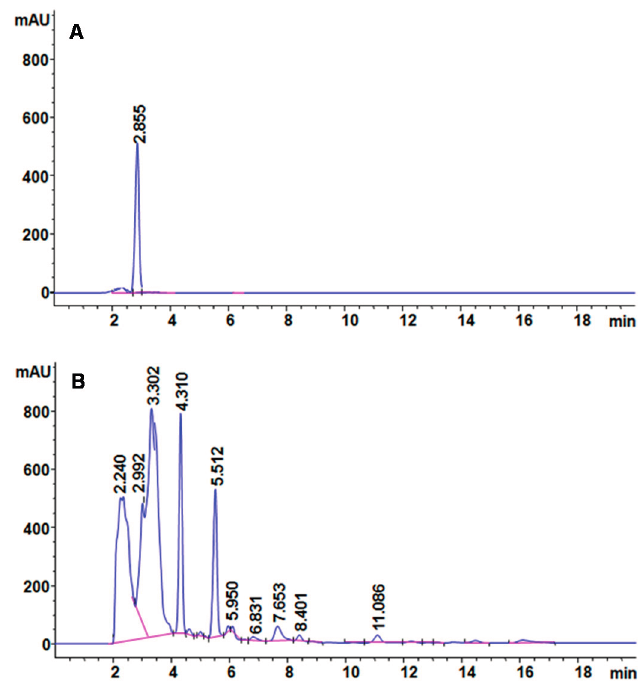
Figure 6. HPLC profile of ( A ) CR dye and ( B ) its decolorized products obtained after treatment with PUF-immobilized microbial consortium in an upflow column bioreactor.